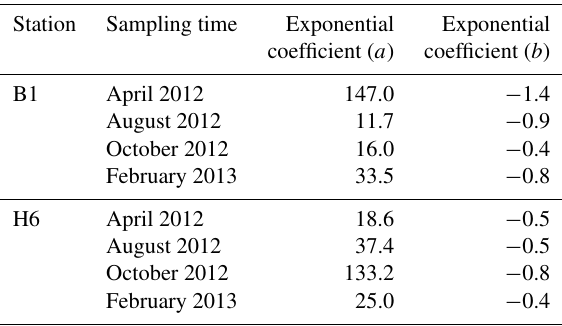
Table 3. Best-fit regression coefficients a and b for the depth